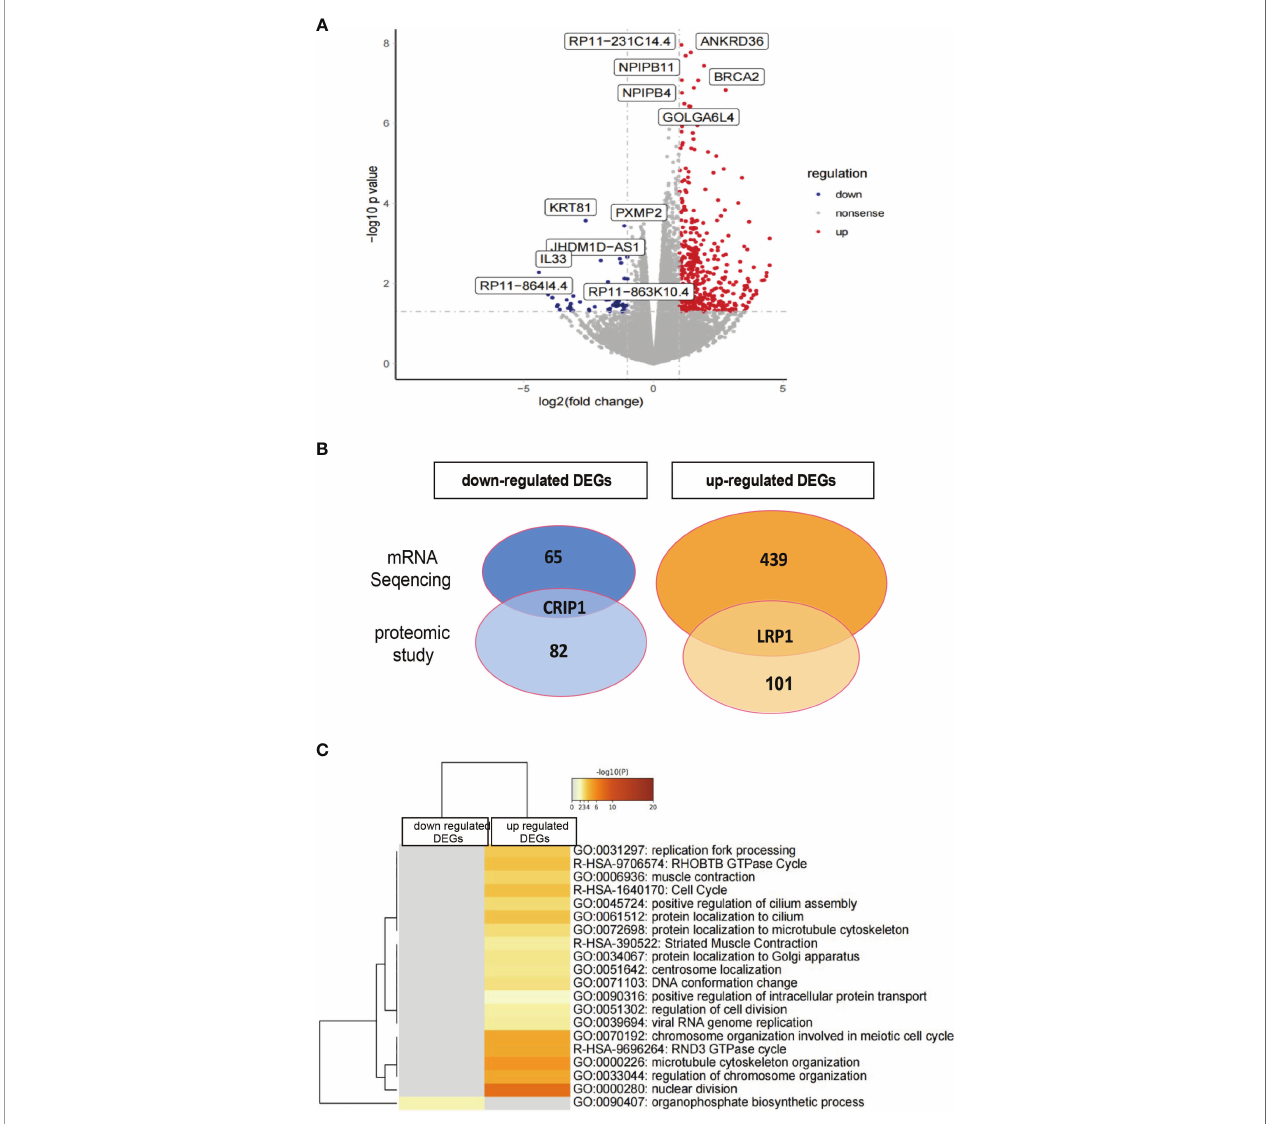
FIGURE 8 | Transcriptome analysis of rHAPLN1-treated RA-FLSs. (A) Among the 504 DEGs detected, 439 were up-regulated and 65 were down-regulated. (B) Two DEGs detected (up-regulated LRP1 and down-regulated CRIP1) were in accordance with the proteomic studies. (C) Metascape analysis of DEGs demonstrated an enrichment of various pathways including replication fork processing, GTPase cycle, cell cycle, and cell